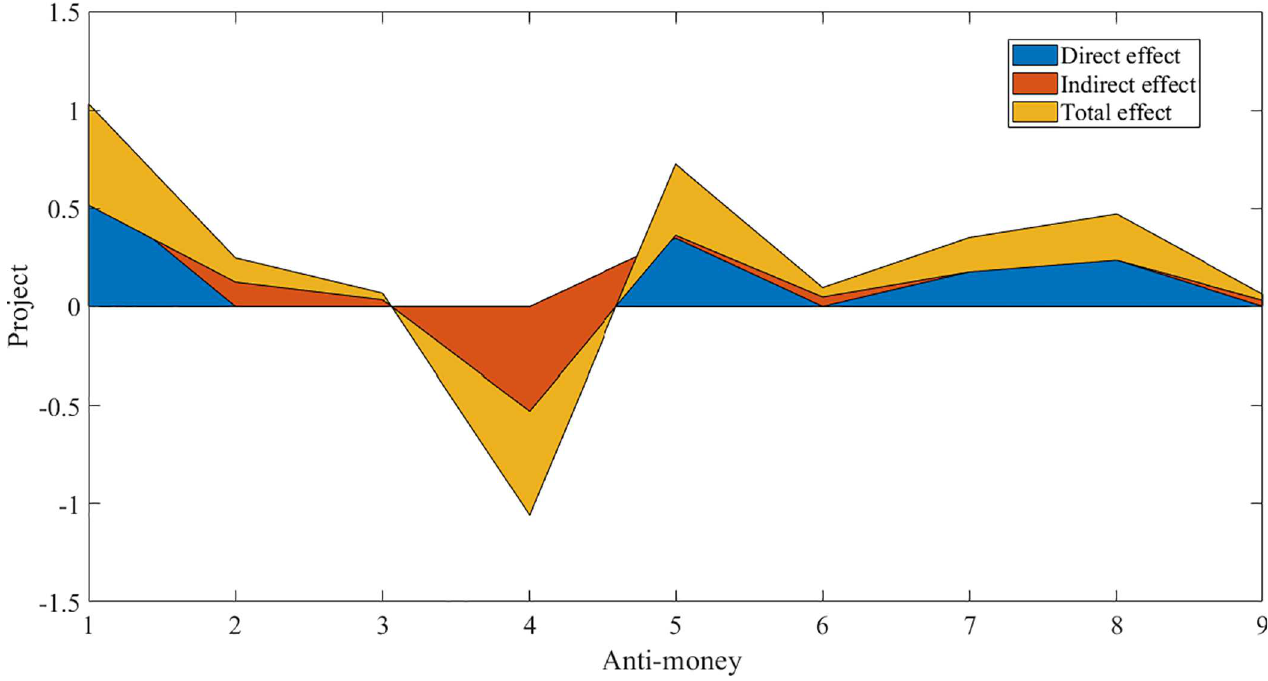
Fig 5. List of calculation results of the effects of various factors on the effectiveness of commercial banks’ anti-money laundering.